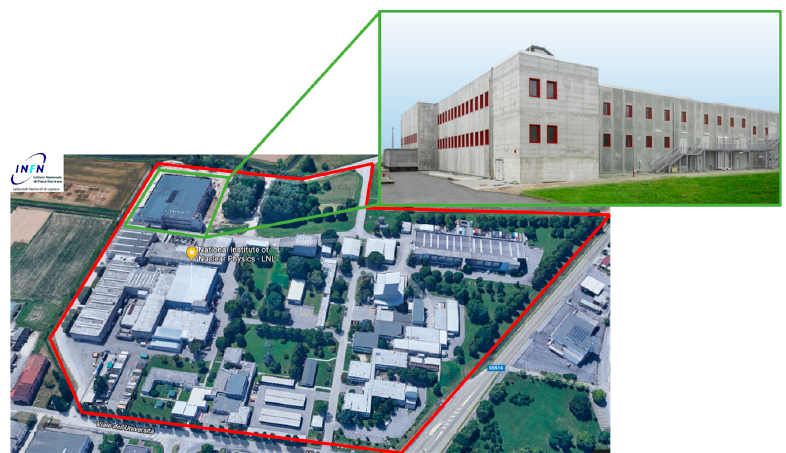
Figure 1. Aerial photo of the INFN-LNL area ( left ) and a zoom on the SPES building ( right ).